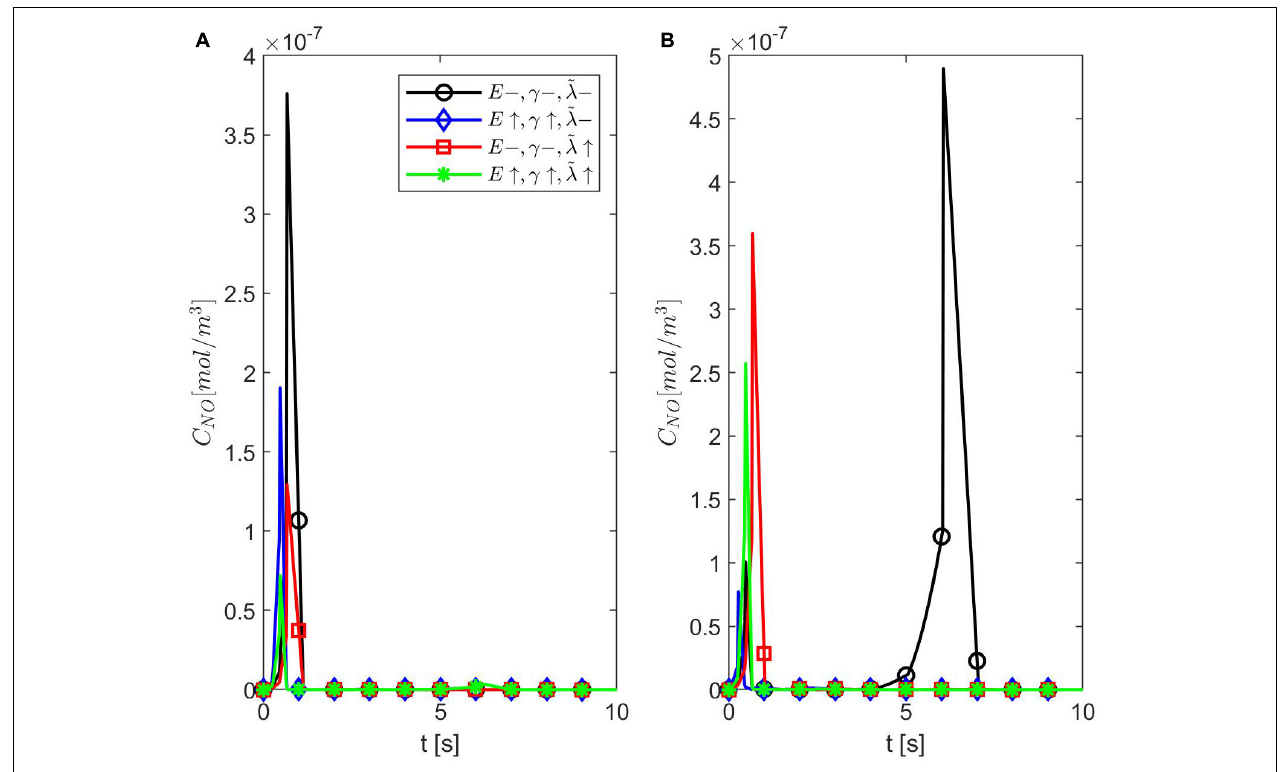
FIGURE 6 | Temporal profiles of C NO at r = a + h , the outer boundary of the endothelium, for ε = 0 . 85 , (A) p = 0 . 75 ( q = 0 . 25 ) , and (B) p = 0 . 25 ( q = 0 . 75 ) ( A,B have the same legend shown in A ). Here E = 6 × 10 3 N / m , γ = 0 . 75 , ˜ λ = 6 . 5325 × 10 3 s − 1 (black circle symbol), E = 6 × 10 4 N / m , γ = 1 . 25 , ˜ λ = 6 . 5325 × 10 3 s − 1 (blue diamond symbol), E = 6 × 10 3 N / m , γ = 0 . 75 , ˜ λ = 13 . 065 × 10 3 s − 1 (red square symbol), and E = 6 × 10 4 N / m , γ = 1 . 25 , ˜ λ = 13 . 0655 × 10 3 s − 1 (green star